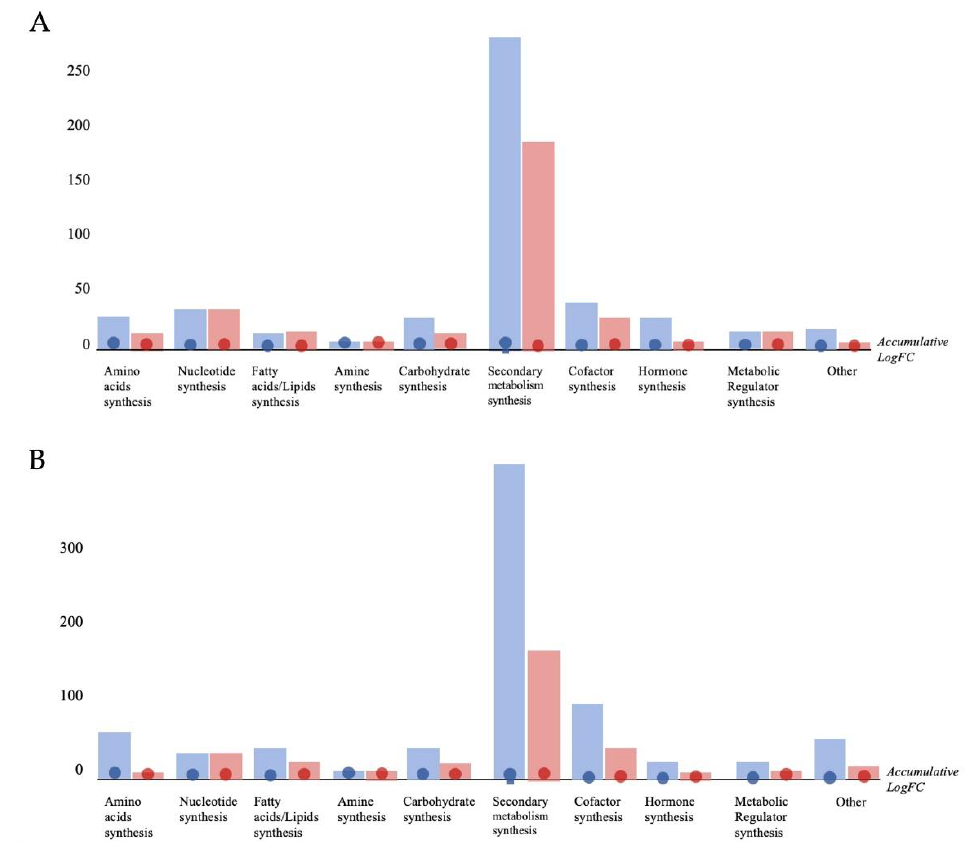
Figure 5. Metabolic processes modulated in maize plants treated with 0.05% LE ( A ) and 1.00% LE ( B ) treatments. VIPs markers were loaded into the PlantCyc Pathway Tool (https://www.plantcyc.org/ Plant Metabolic Network; accessed on 20 November 2021). The x axis represents each set of metabolic subcategories, while the y axis corresponds to the accumulative log fold change (FC). The large dots represent the average (mean) of all FCs for the different metabolites in the class, while the small dots represent the individual log FC.